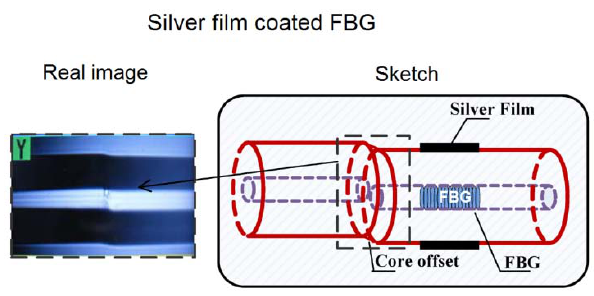
Figure 5. Schematic of the set-up proposed in [60]. FBG-based thermal